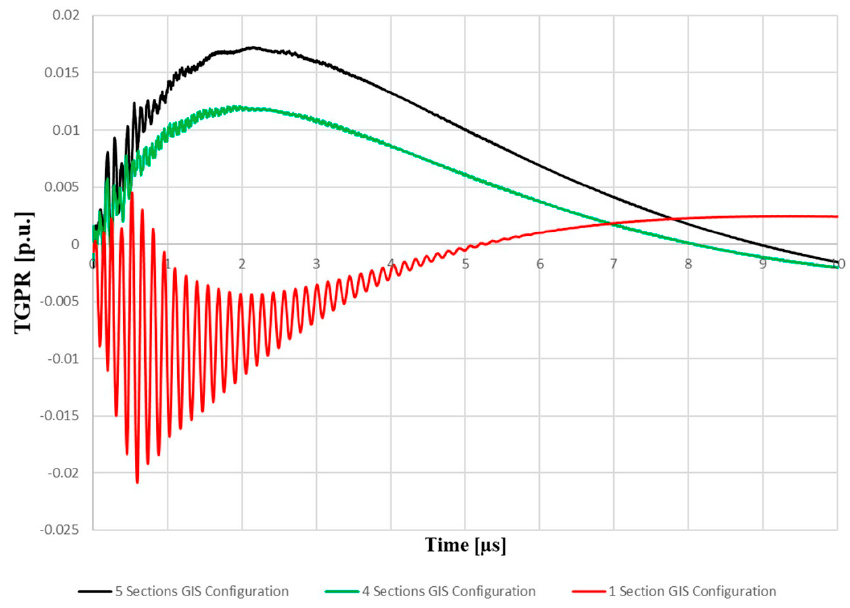
Figure 12. TGPR on the copper strip located on the inner wall of GIS building.